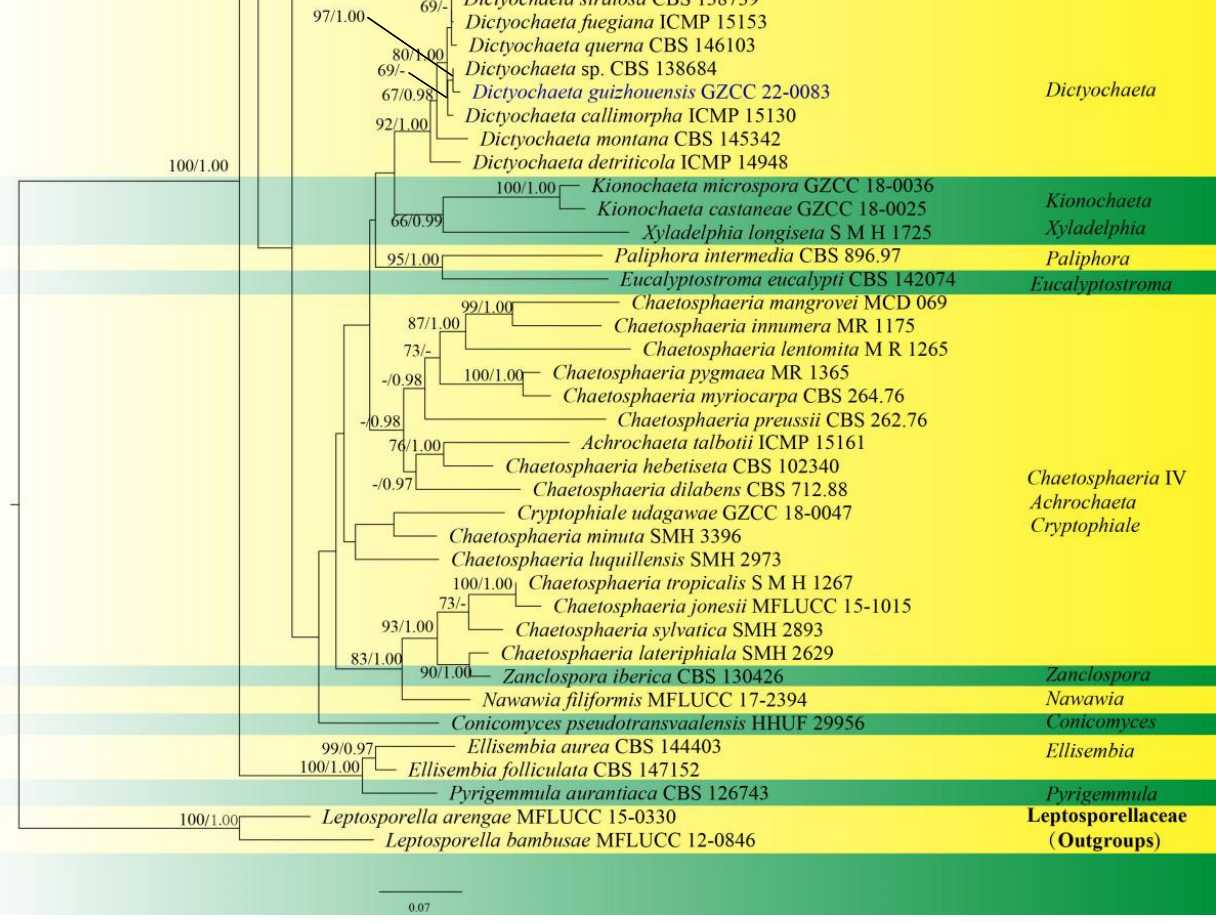
Figure 1. The phylogenetic tree generated from ML analysis that is based on a concatenated LSU-ITS dataset for the Chaetosphaeriaceae family. Bootstrap support values for ML equal to or greater than 65% and Bayesian posterior probabilities (PPs) equal to or greater than 0.95 were indicated above or below the nodes as ML/PP. Leptosporella arengae ( MFLUCC 15-0330) and L . bambusae (MFLUCC 12-0846) were selected as the outgroup taxa. The newly obtained sequences are indicated in blue.